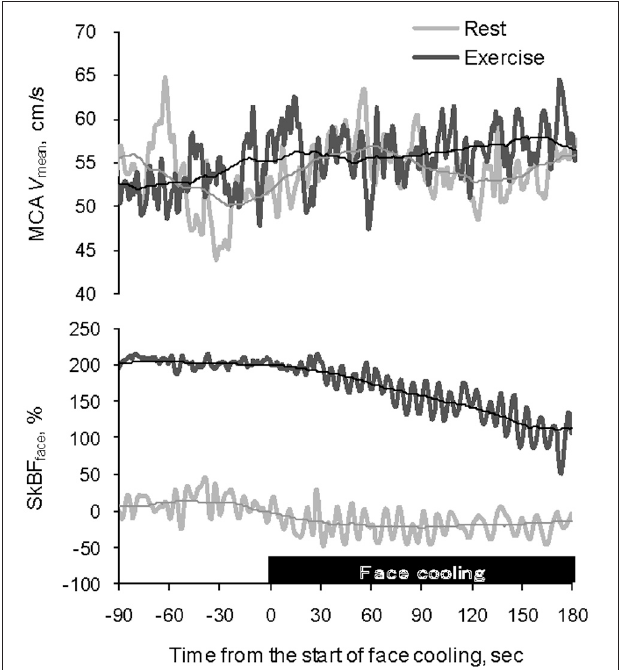
FIGURE 1 | Typical example of recordings of MCA V mean and SkBF face at rest (gray) and during exercise (black) showing the effect of facial cooling. Each thin line represents a moving average for 1min. MCA V mean , middle cerebral artery mean blood velocity; SkBF face , forehead skin blood